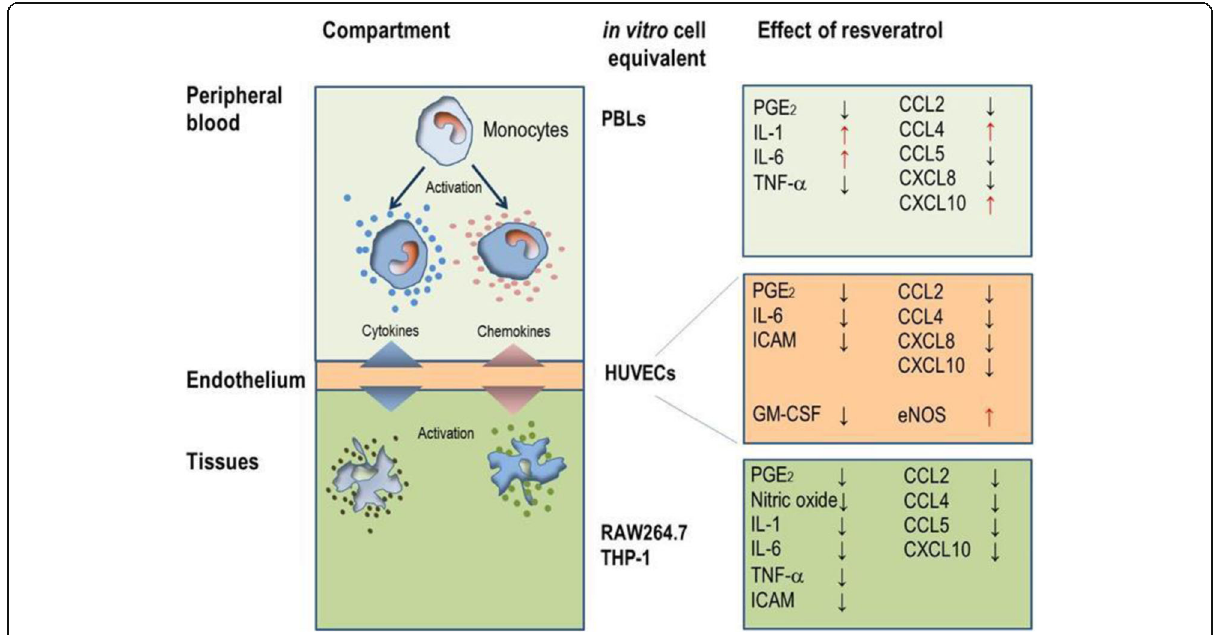
Fig. 8 Context-dependent and cell-specific effects of RES. Peripheral blood monocytes respond to inflammatory stimuli by increased production of cytokines and chemokines. Similarly, endothelial cells secrete large amounts of inflammatory metabolites at conditions of endothelial dysfunction induced by TNF- α . Activated monocytes trans-migrate through endothelial layers and differentiate into tissue-resident macrophages. During acute or chronic inflammation, macrophages respond to stimuli by the production or release of numerous cytokines and chemokines. RES blunts ( black arrows ) or enhances ( red arrows ) cytokines, chemokines and adhesion molecules and thus intervenes in trafficking, activation and differentiation of immune cells in different